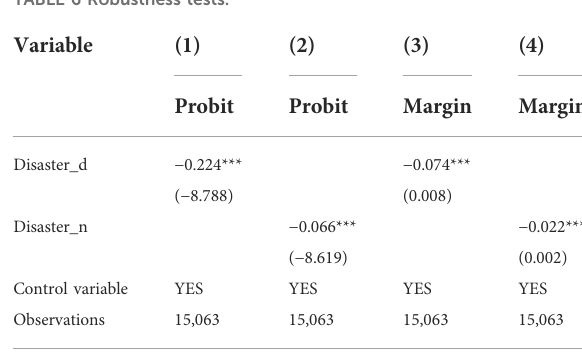
TABLE 6 Robustness tests.